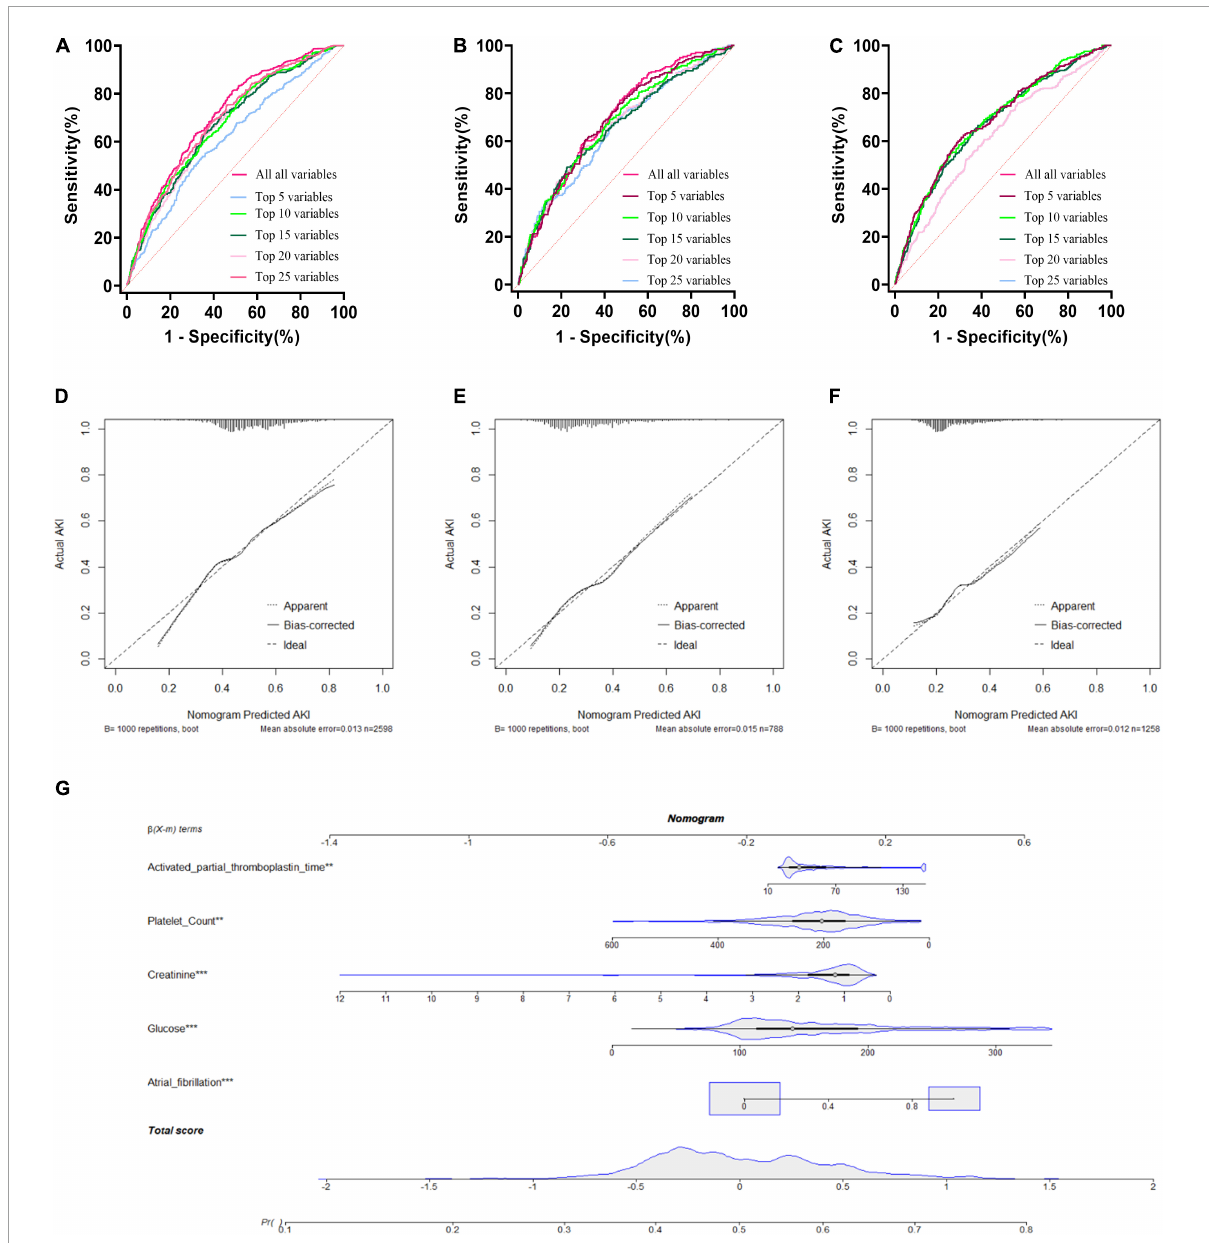
FIGURE3 Logistic Regression model with different variables ROC curves; training cohort (A) ; test cohort (B) ; validation cohort (C) . Logistic Regression model calibration curve; training cohort (D) ; test cohort (E) ; validation cohort (F) . Logistic Regression model Nomogram (G) .